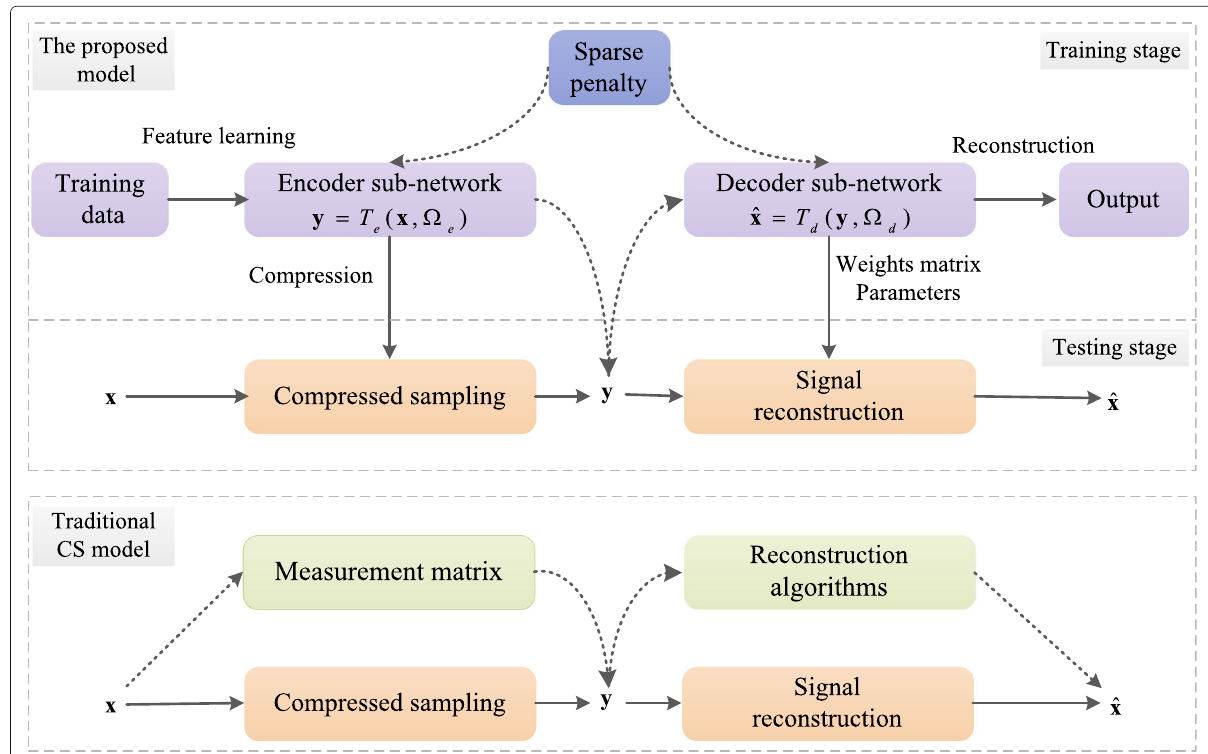
Fig. 1 Comparison between traditional CS model and the proposed